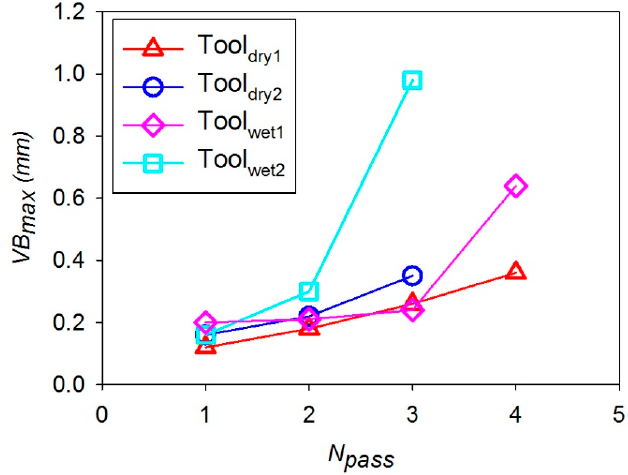
Figure 8. VB max versus the number of passes for the two milling conditions, Tool dry (dry milling) and Tool wet (wet milling), for f t = 0.1 mm/rev.